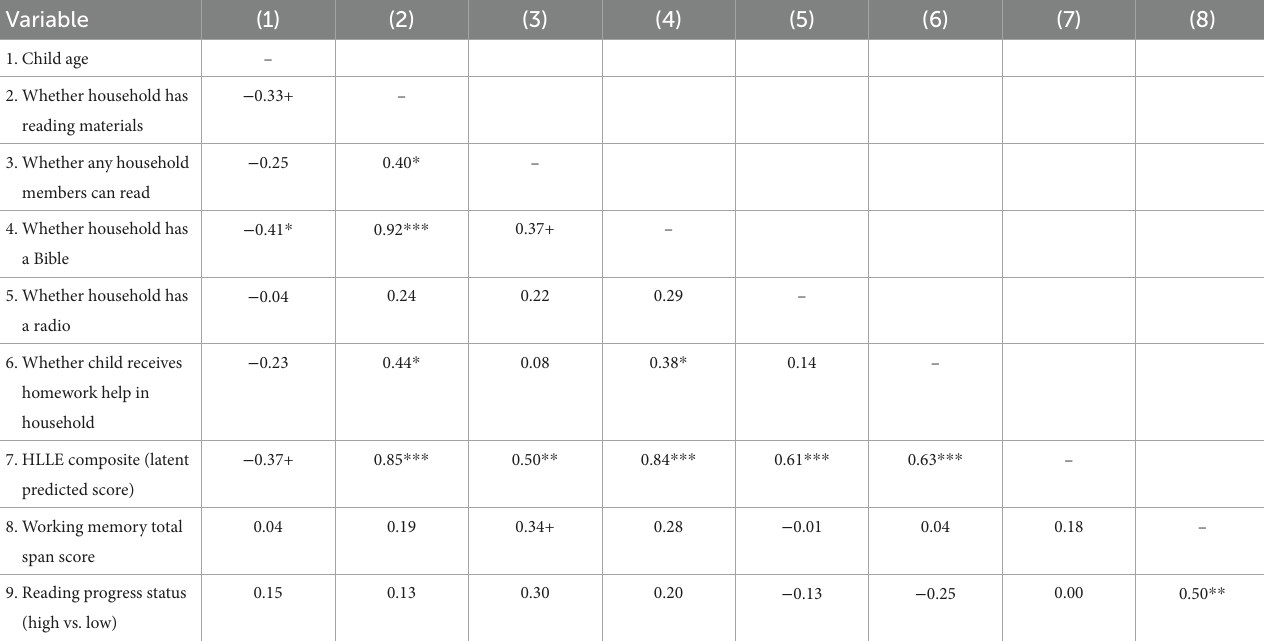
TABLE 2 Bivariate correlations.